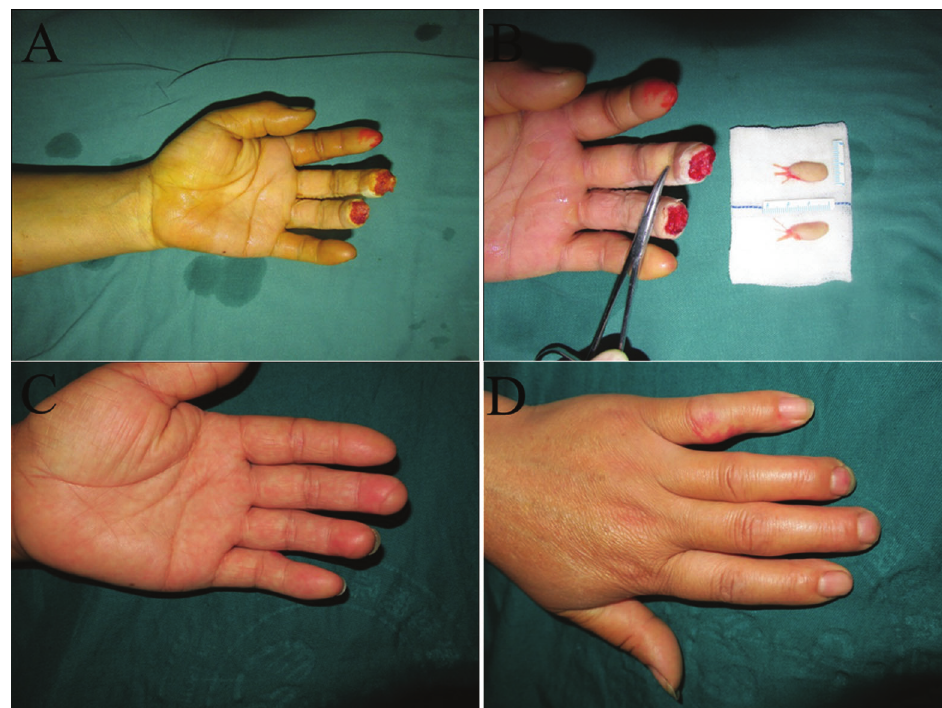
Figure 4 - In this patient, the injured fingertips after debridement (A), the flaps before transplantation (B), and the volar (C) and dorsal (D) appearances after 6 months. In this case, the patient injured the left middle and ring fingertips. The middle finger received an artery-only free medial flap of the second toe, while the ring finger received a routine free medial flap of the third toe.